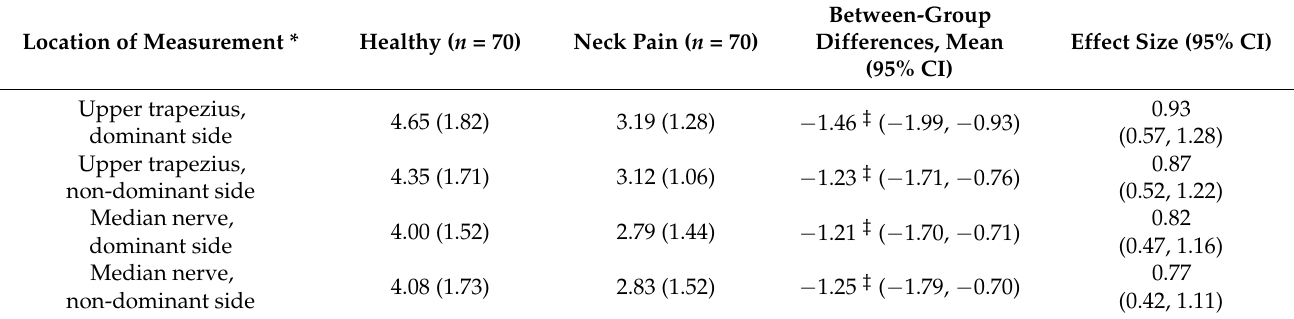
Table 2. Between-group differences in pressure pain threshold measurements (kg/cm 2 ).